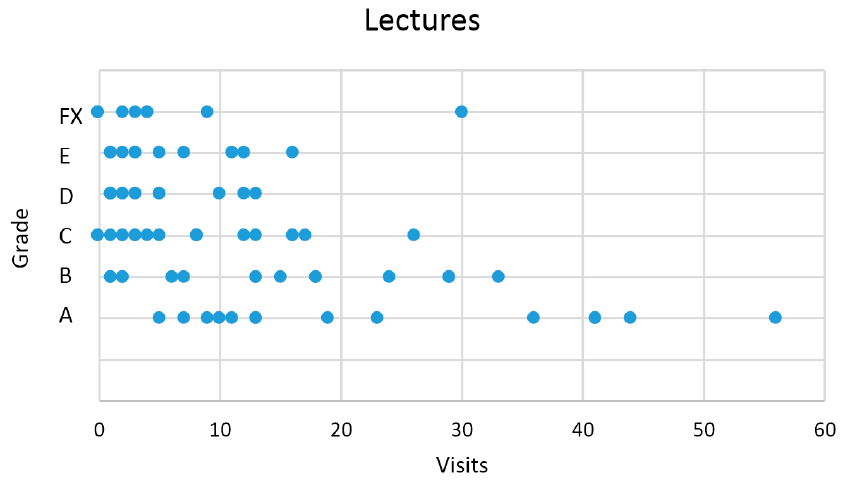
Figure 7. Grades based on visits in “Lecture” materials.